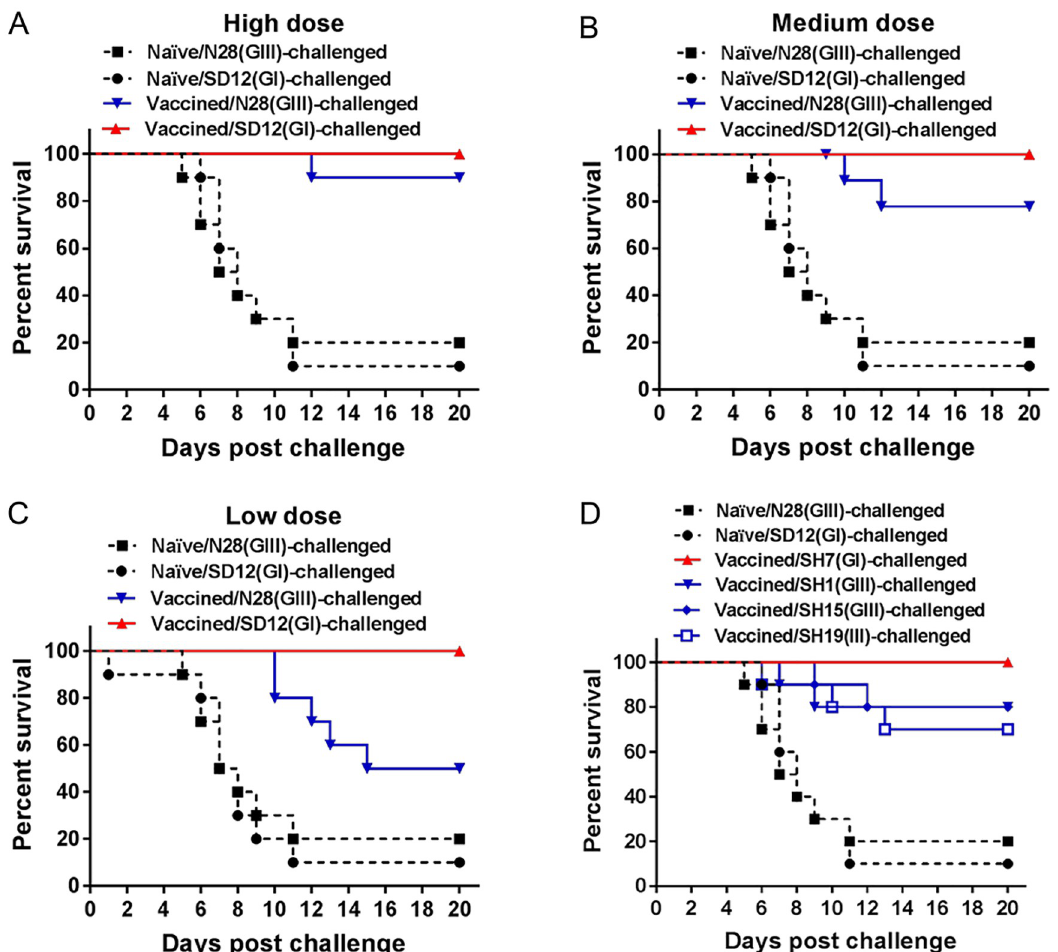
Fig 4. Protective efficacy of a SD12(GI)-inactivated vaccine. Mice ( n = 10) were mock-vaccinated (Na ï ve) or immunized with SD12(GI)-inactivated vaccine at high (10 5 PFU) dose (A), medium (10 4 PFU) dose (B and D) and low (10 3 PFU) dose (C), and challenged with the indicated JEV